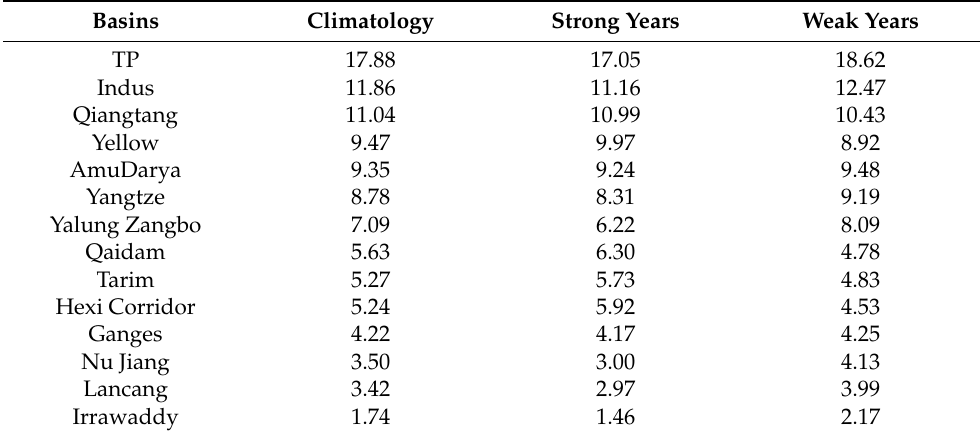
Table 4. The value of PRR under different WVT conditions (unit: